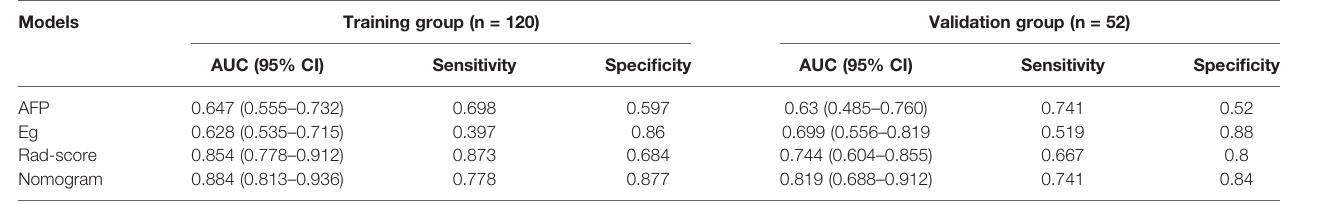
TABLE 3 | Diagnostic performance of the various models. Models